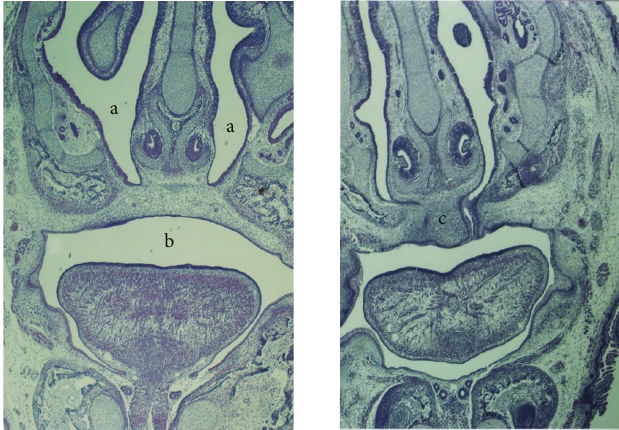
Figure 2: Histopathological slides of the frontal section of the head, 17-day fetuses in the control (left) and the group received high doses of fluoxetine and olanzapine (right) (H&E staining, 4x). In the control group (left), the nasal septum is attached to the roof of the mouth and nostrils (a) are completely separated from the oral cavity (b). In the fetus from the group that received high doses of fluoxetine and olanzapine (right), there is unilateral clefting of the palate (c).